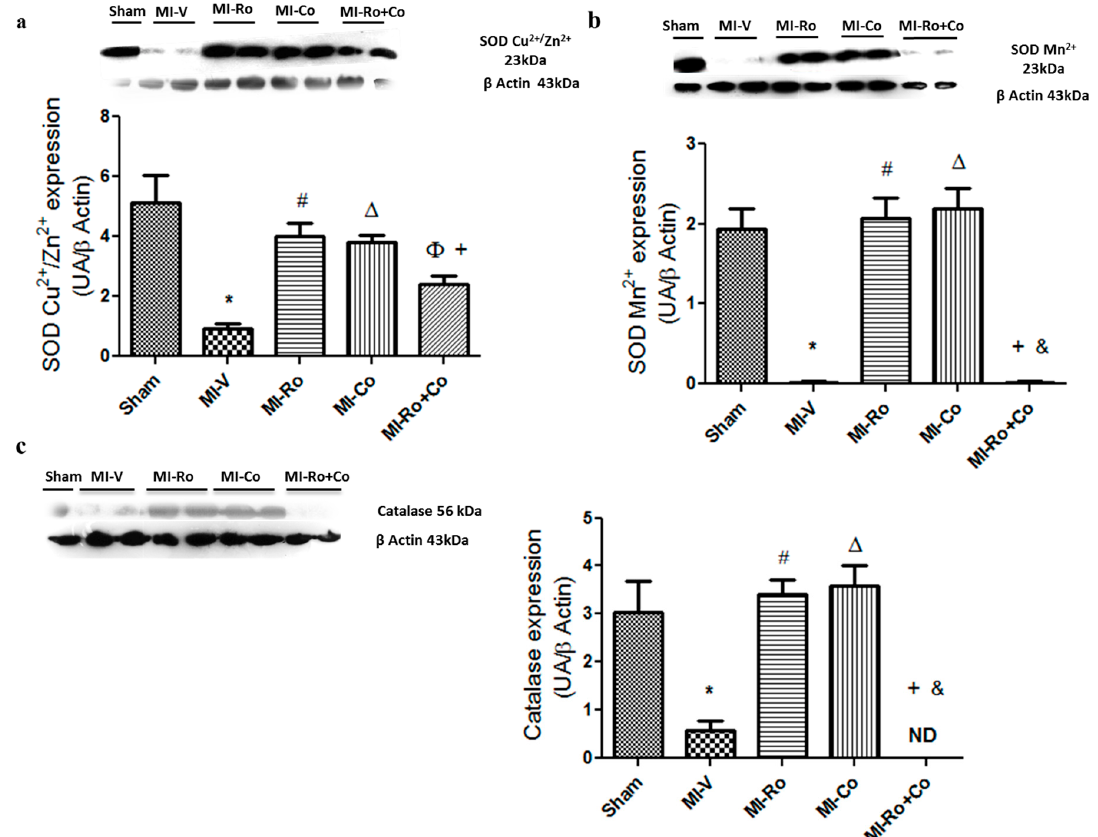
Figure 3. The effect of extracts from Rosmarinus officinalis ( Ro ), Crataegus oxyacantha ( Co ), and their combination ( Ro+Co ) on superoxide dismutase (SOD)-Cu 2+ /Zn 2+ ( a ); SOD-Mn 2+ ( b ); and catalase ( c ) protein expression in ischemic left ventricle area from sham, myocardial infarction (MI)-vehicle treated, MI- Ro , MI- Co , and MI- Ro+Co experimental groups. The values show the mean ± SEM ( n = 6 per group). p < 0.05 ANOVA one way post Tukey * Sham vs. MI-V, # MI-V vs. MI- Ro , Δ MI-V vs. MI- Co , Φ MI-V vs. MI- Ro+Co , + MI- Ro vs. MI- Ro+Co , & MI- Co vs. MI- Ro+Co . ND (Not detected).